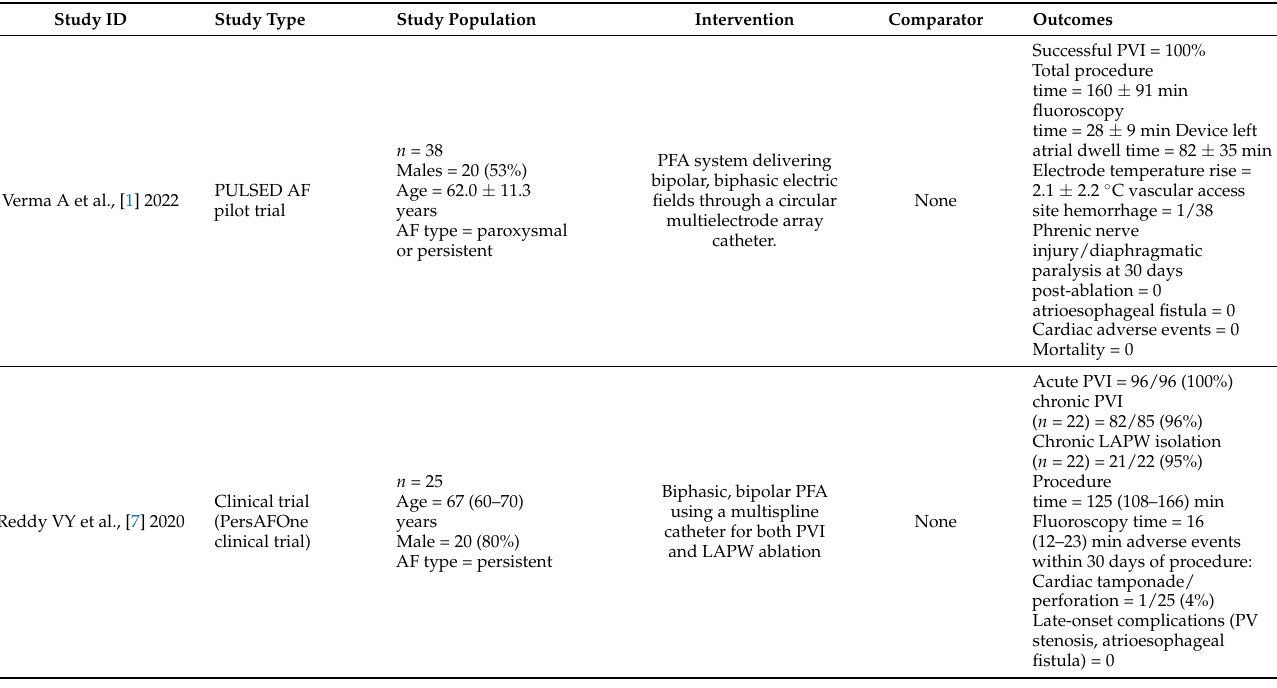
Table 1. Number of participants in included studies.